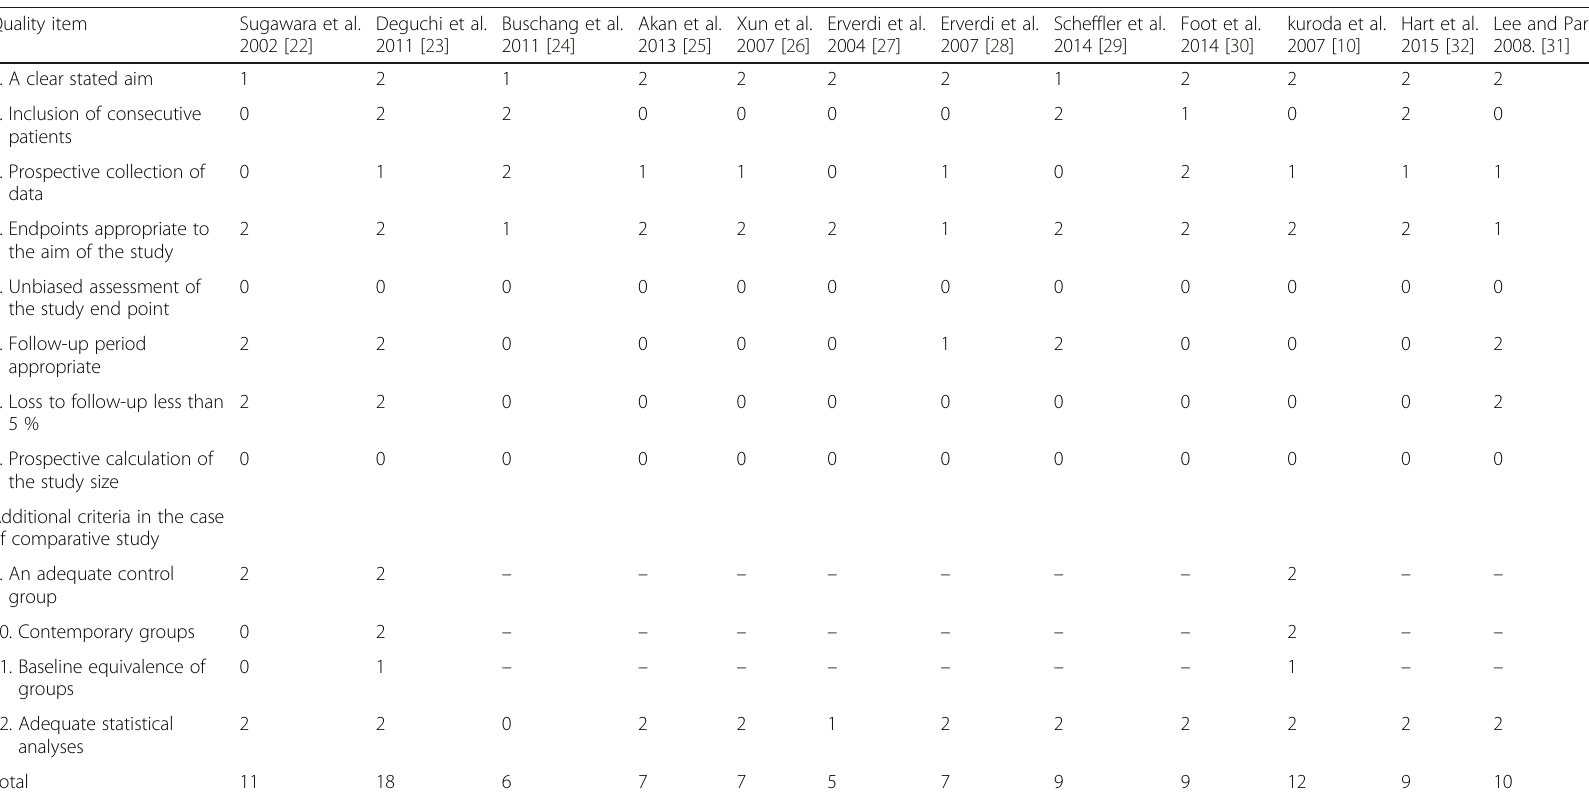
Table 2 Risk of bias assessment of included